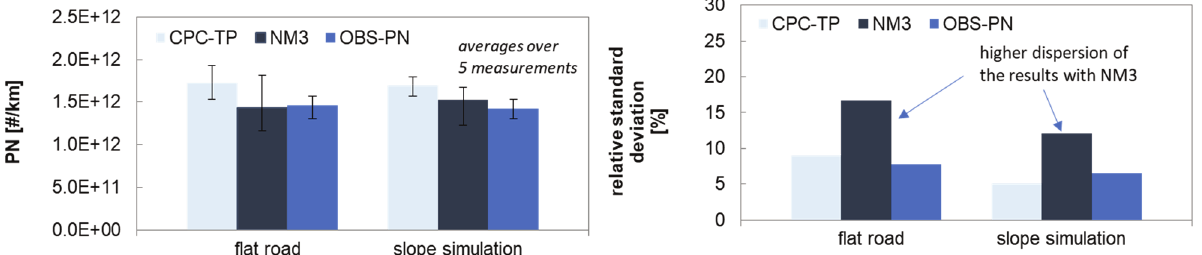
Fig. 16. Simultaneous measurements of PN at tailpipe with ViPR+CPC3790, NM3 and OBS-PN on chassis dyno; HORIBA OBS One; Volvo